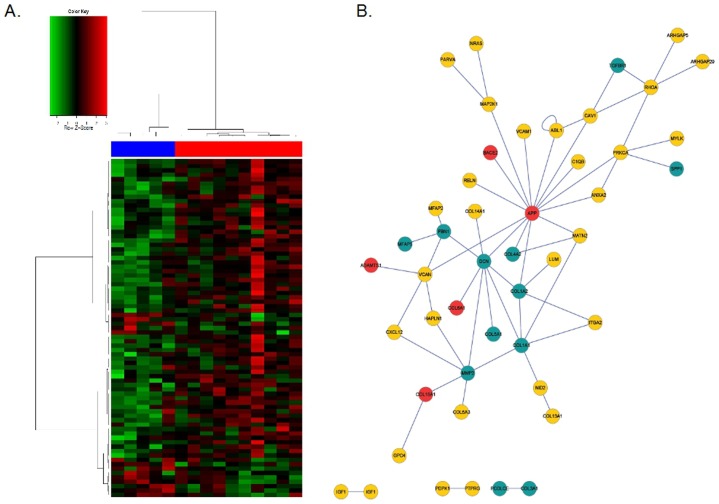
The role of FBN1 and related genes in DS and in MFS.(A) Heatmap of the 77 genes with an absolute TBV greater than 2.58 from the Bayesian Analysis without genes on HSA21 (blue; control samples, red: DS samples). (B) Network reconstruction from all genes (N = 85) with an absolute TBV greater than 2.58 (red nodes; genes on HSA21, green nodes; MFS related genes).